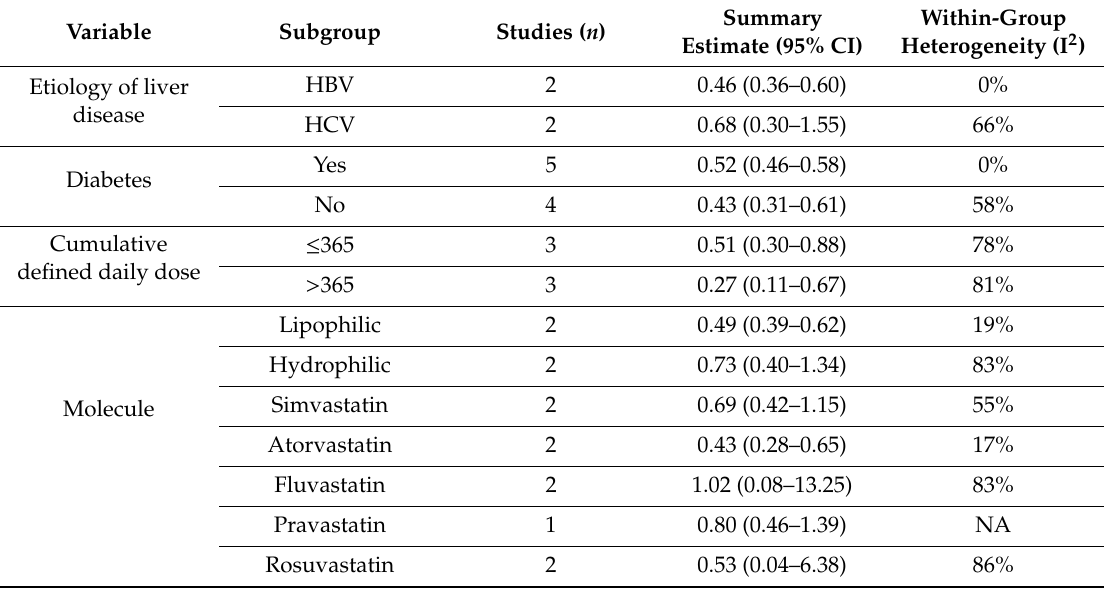
Table 2. Subgroup analysis for adjusted hazard ratio concerning hepatocellular carcinoma occurrence.